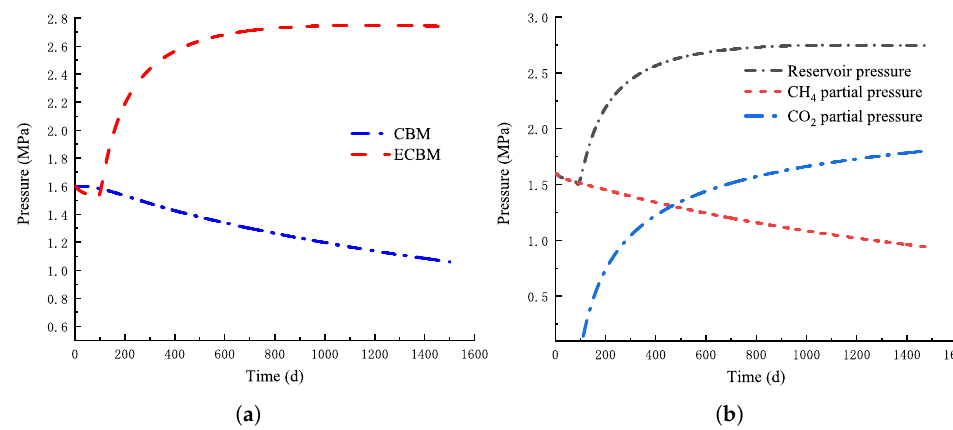
Figure 9. Variation curve of reservoir pressure at reference point B. ( a ) Comparison of CO 2 - ECBM and CBM ( b ) CO 2 , CH 4 partial pressure and total reservoir pressure of CO 2 - ECBM .